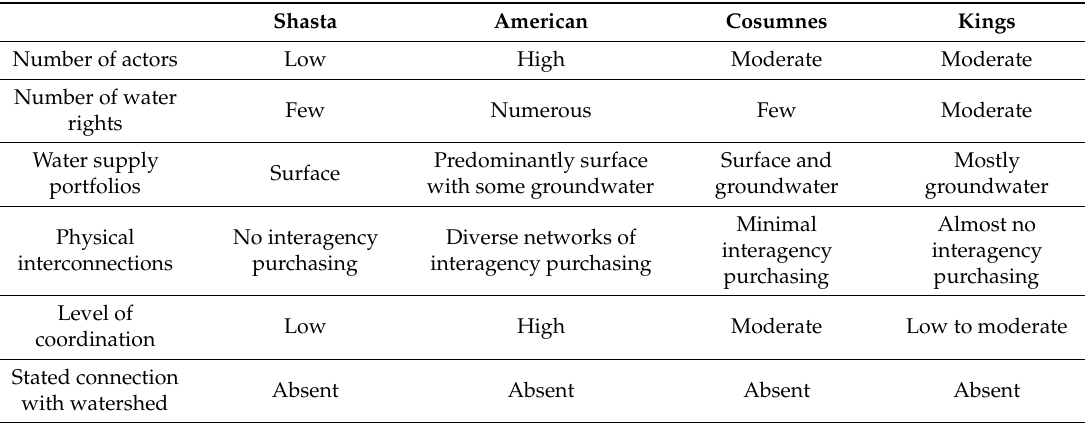
Table 5. Summarizing watershed